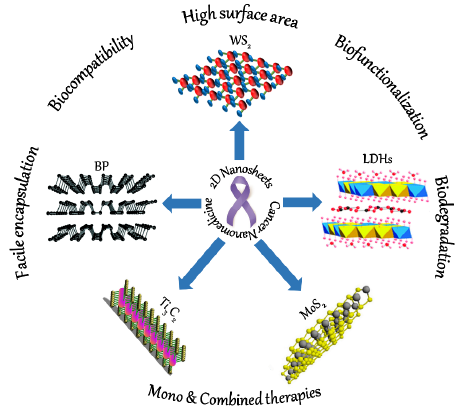
Figure 2. Schematic illustration of the different 2D NSs and their advantages for versatile cancer therapeutics. BP (adapted from Reference [17], Materials Horizons, published by The Royal Society of Chemistry, 2017), Ti 3 C 2 (adapted with permission from Reference [18], Journal of Molecular Liquids, published by Elsevier, 2020), MoS 2 (adapted with permission from Reference [19], Langmuir, published by American Chemical Society, 2017), WS 2 (adapted from Reference [20] under the terms of the Creative Commons Attribution 4.0 International License), and LDHs (adapted from Reference [21], RSC Advances, published by The Royal Society of Chemistry, 2014). All the described nanosheets (NSs) were designed and are modified innovatively based on their treatment of various cancer types. Therefore, we provide a brief outline of the properties and advantages of each NS to provide readers with the current strategies followed by the scientists. In most cases, NSs are used for combined therapies to release